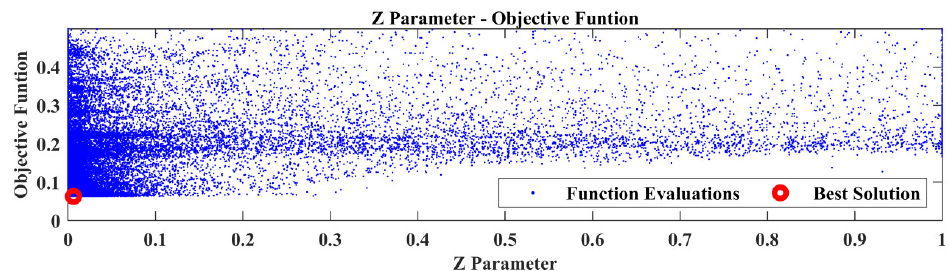
Figure 15. Case 2: Z parameter versus the Objective Function values.